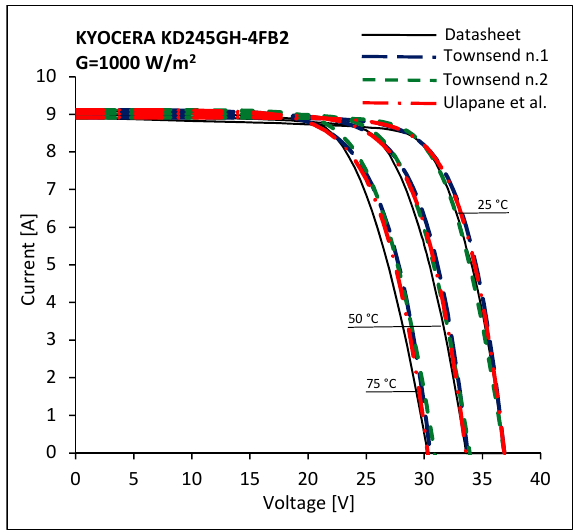
Figure 11. Comparison between the issued I-V characteristics of the Kyocera KD245GH-4FB2 at G = 1000 W/m 2 and the characteristics calculated by means of the Townsend n.1, the Townsend n.2 and the Ulapane et al. models.